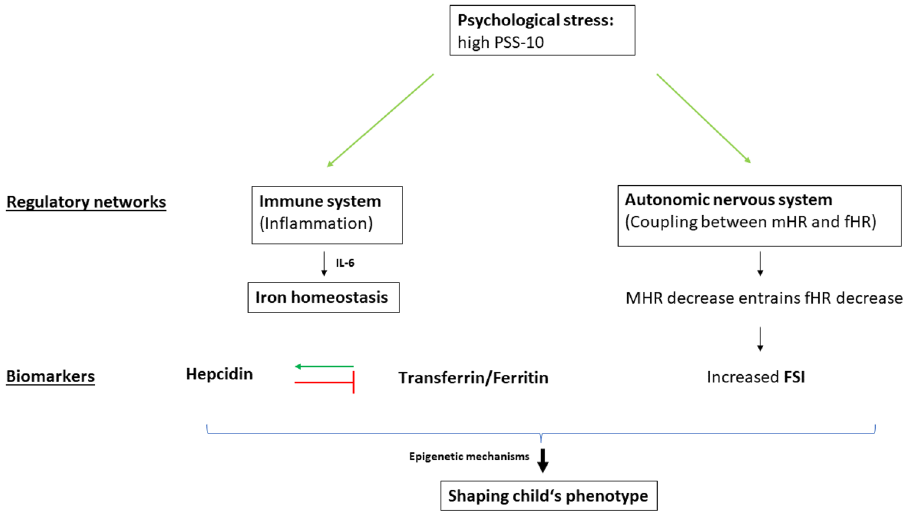
Figure 1. Putative link of PS with iron homeostasis and maternal–fetal heart rate coupling. A proposed simplified model of the hepcidin–placental–ferroportin axis based on the articles of Cortes et al. 15 and Lobmaier et al. 10 : Hepcidin is the key regulator within this system. By binding to ferroportin, it prevents the release of iron into the bloodstream and therefore the synthesis of the transport protein transferrin and the storage protein ferritin. Hepcidin levels are influenced strongly by inflammatory processes, especially the cytokine IL-6. Another possible pathway influencing the child’s stress phenotype is assumed to be realized by interference in the coupling between maternal and fetal heart rate (mHR, fHR) as seen during maternal expiration. PSS perceived stress scale, FSI fetal stress